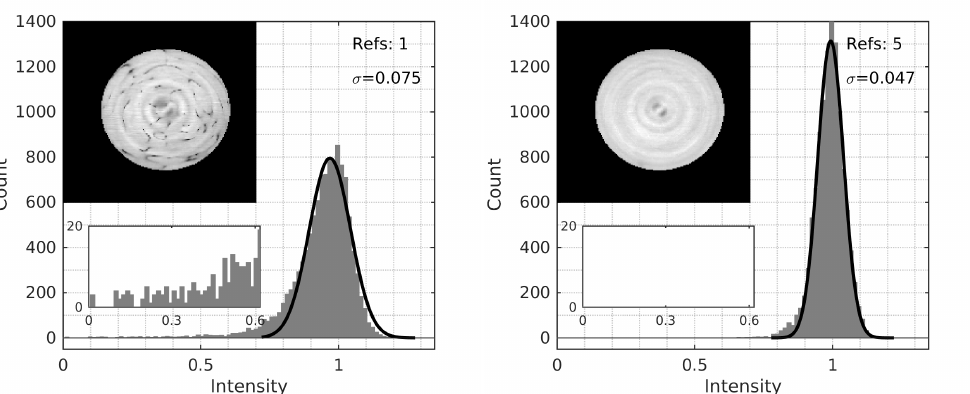
Figure 2. Histogram of output mode intensity obtained from a single-reference transmission matrix (TM) compared with a TM determined from a combination of five internal reference modes. The intensity is normalised to the mean value in order to allow comparison if the standard deviations of the histogram peaks for the different configurations. Top-left insets show the maps intensities of the fibre facet. Further, bottom insets show the zoom of the histogram on the intensity values in the range of